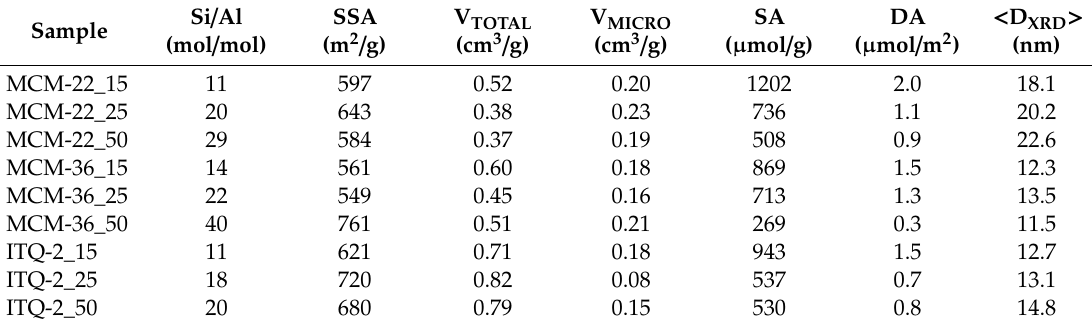
Table 1. Si / Al molar ratio, textural, and acidic properties of the zeolitic samples.